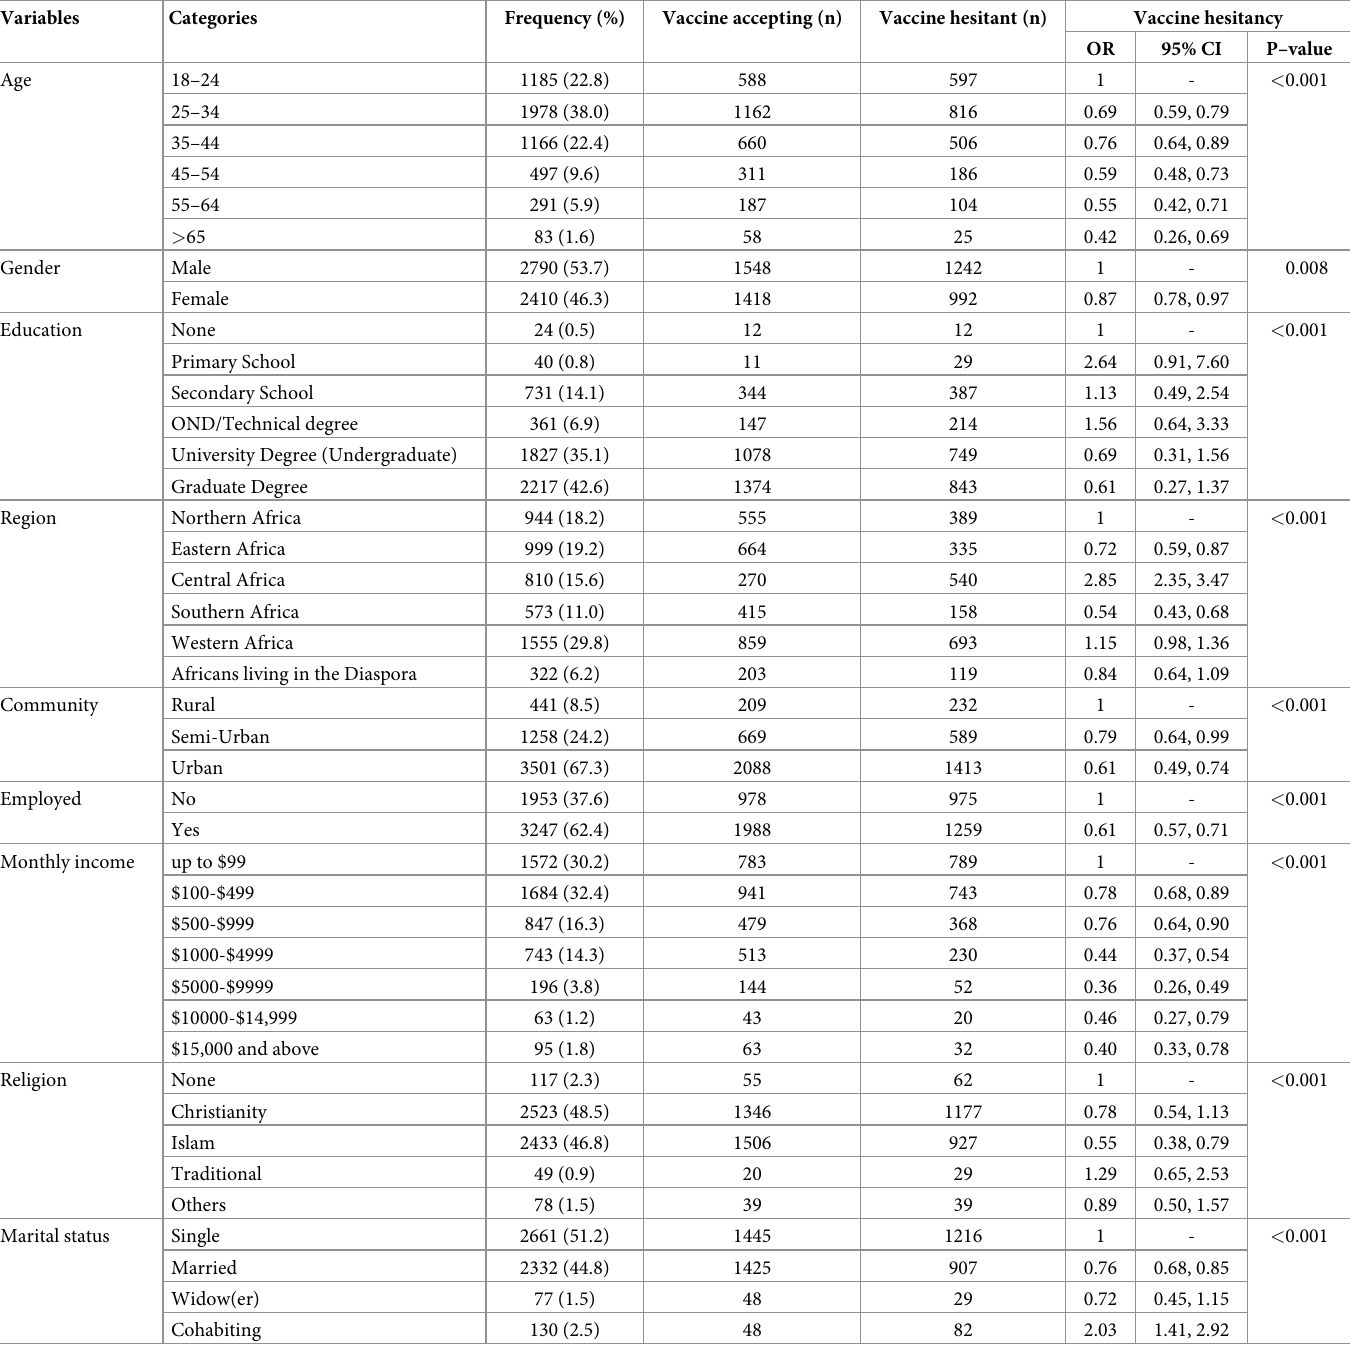
Table 2. Sociodemographic predictors of COVID-19 vaccine